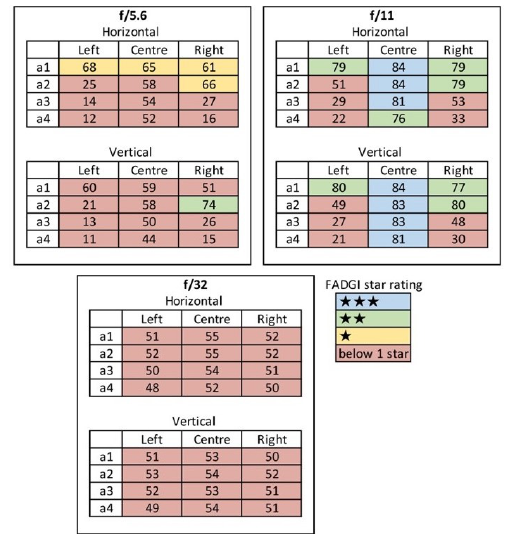
Table 1. DOF-3D-Plane sampling efficiency (%) and colour coded FADGI star rating. Results are provided for three areas of the DICE target (left, centre, right).